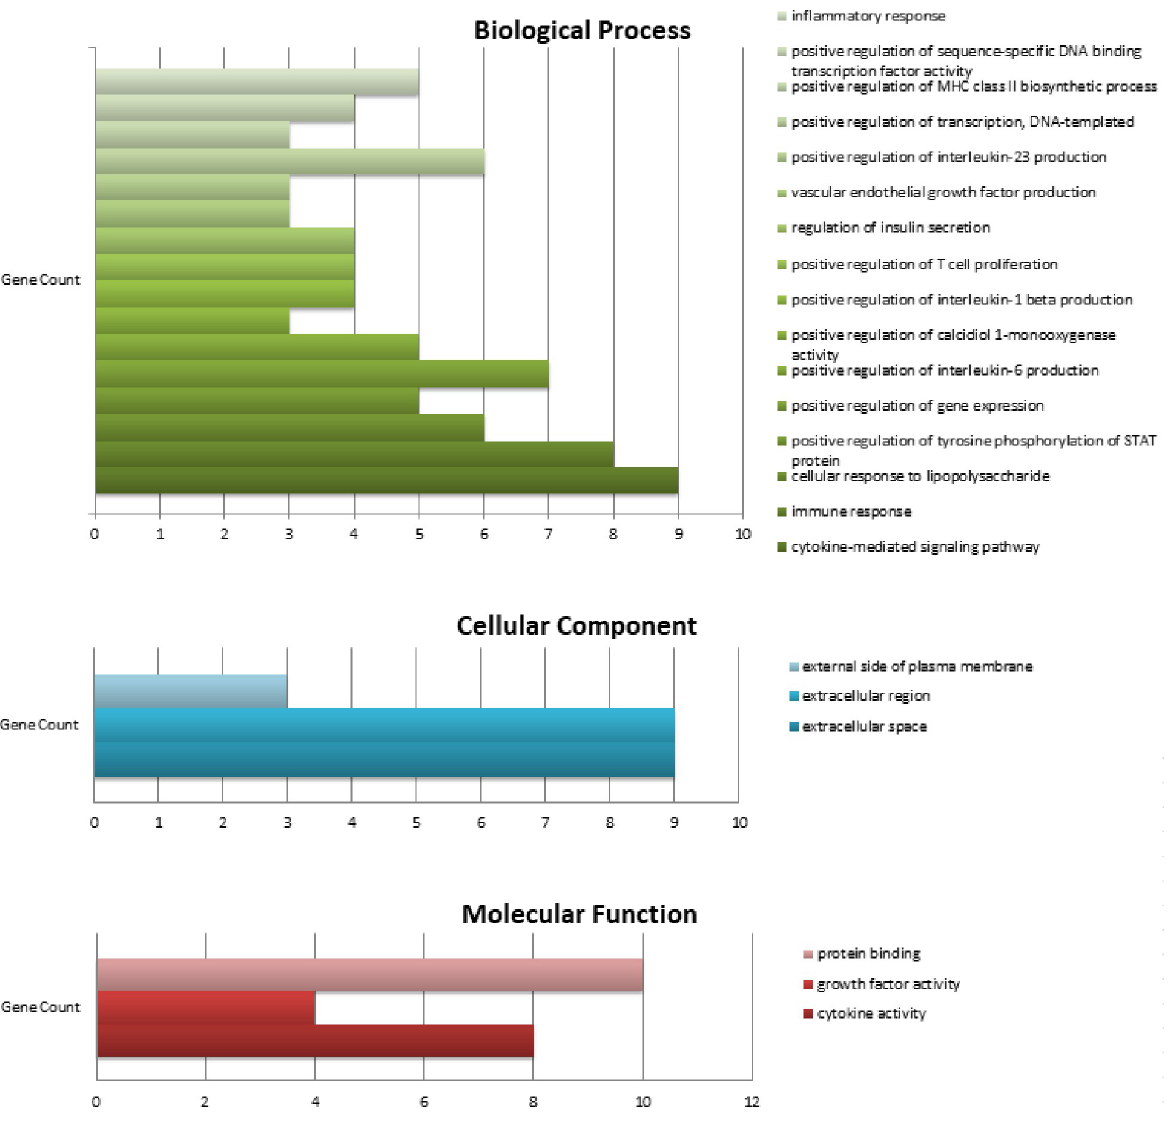
Fig 5. Gene Ontology Enrichment Analysis: Biological Process (BP), Cellular Component (CC) and Molecular Function (MF) were predicted for the given set of hub genes in the DAVID tool.